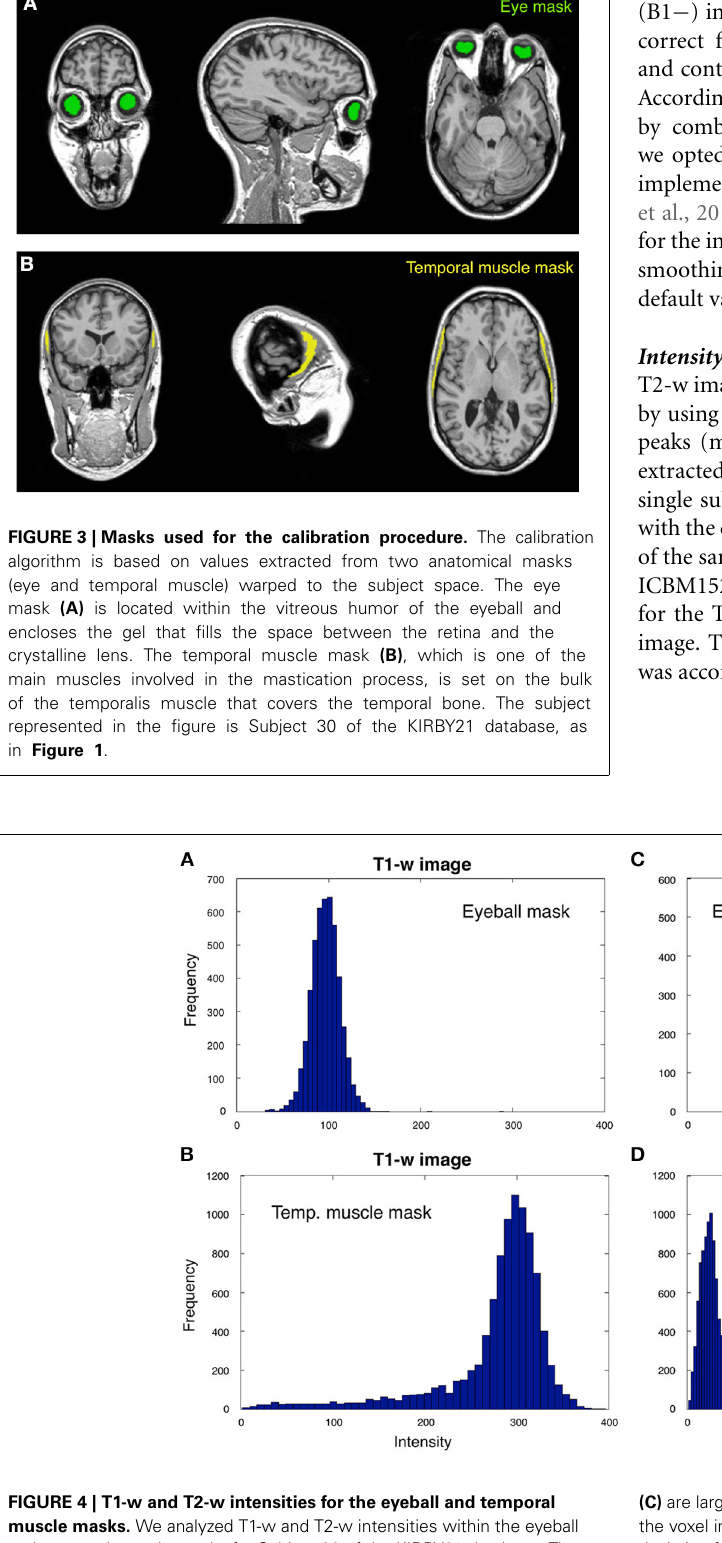
(C) are larger than the ones bounded by the temporal muscle mask (D) . Since the voxel intensities in the two masks generally showed distributions deviating from a Gaussian trend, we selected reference values as the distribution peak (i.e., the numerical mode) rather than the statistical mean or